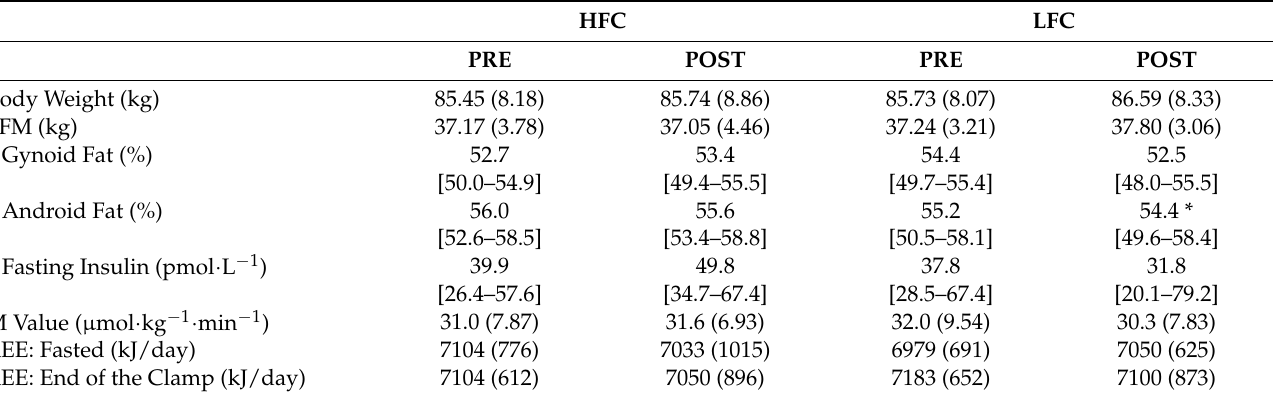
(HFC) or low-flavanol (LFC) cocoa